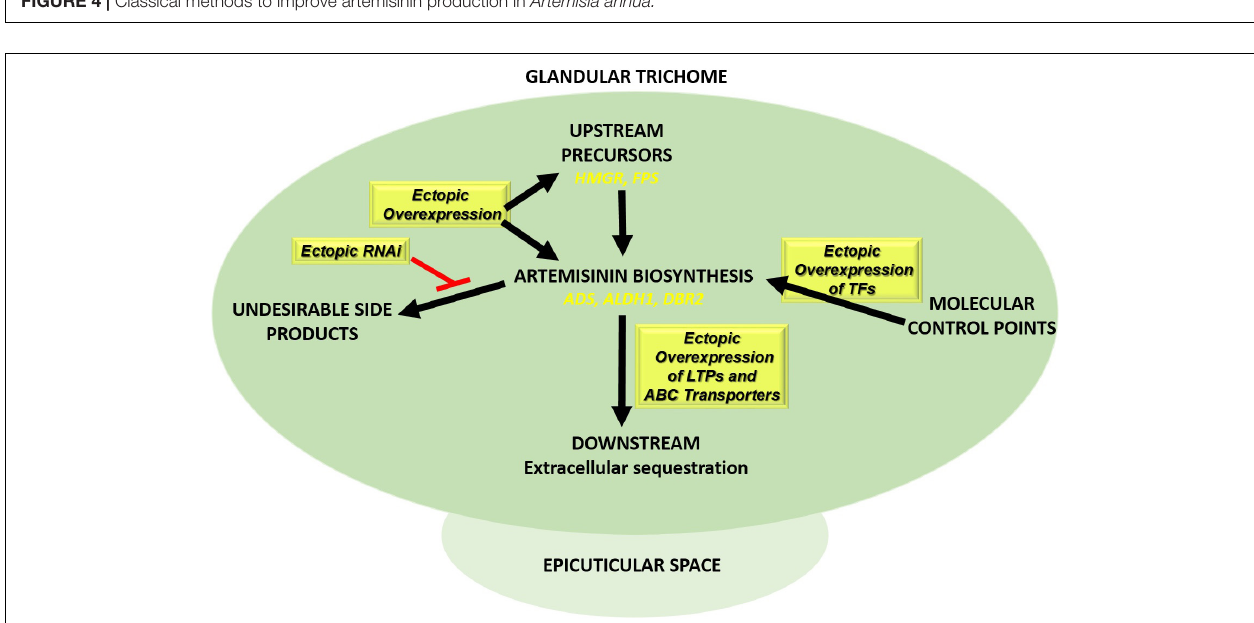
FIGURE 5 | Transformation approaches in Artemisia annua plants to boost artemisinin production. Ectopic overexpression of biosynthetic pathway genes ( ADS , ALDH1 , and DBR2 ), transcription factors (e.g., AP2/ERF, MYB, WRKY, and bHLH), and genes involved in extracellular sequestration of artemisinin (LTPs/PDRs) together with ectopic RNAi expression of competing pathways such squalene biosynthesis (SQS